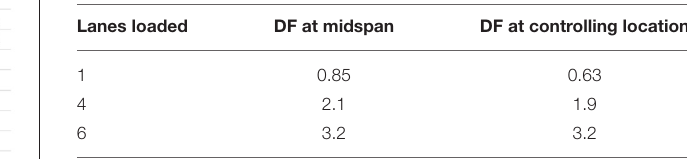
TABLE 3 | Baseline response live load distribution factors.